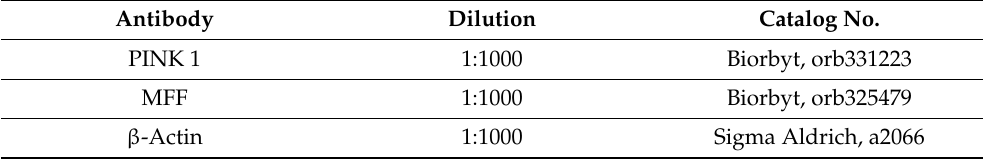
Table 2. List of antibodies employed for protein profiling using western blot analysis. Antibody Dilution Catalog No. PINK 1 1:1000 Biorbyt, orb331223 MFF 1:1000 Biorbyt, orb325479 β -Actin 1:1000 Sigma Aldrich,